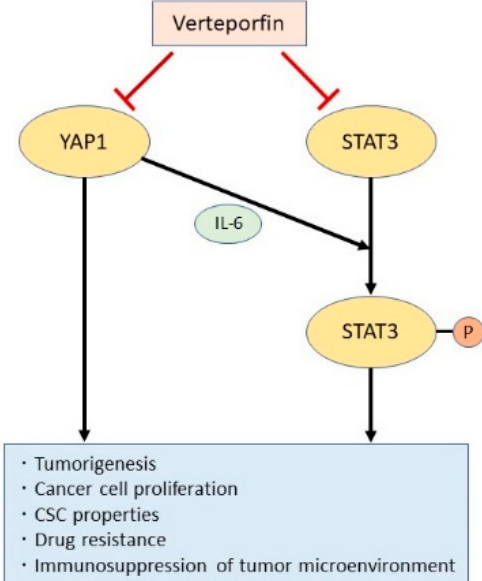
Figure 3. YAP1 and STAT3; Two oncogenic pathways that promote cancer stemness. YAP1 and STAT3 are independently involved in oncogenic signaling to promote cancer stem cell (CSC) properties. However, YAP1 also promotes IL-6-induced STAT3 phosphorylation and activation. The porphyrin derivative verteporfin inhibits both the YAP1 and STAT3 pathways and may thus be an efficient suppressor of CSC properties.